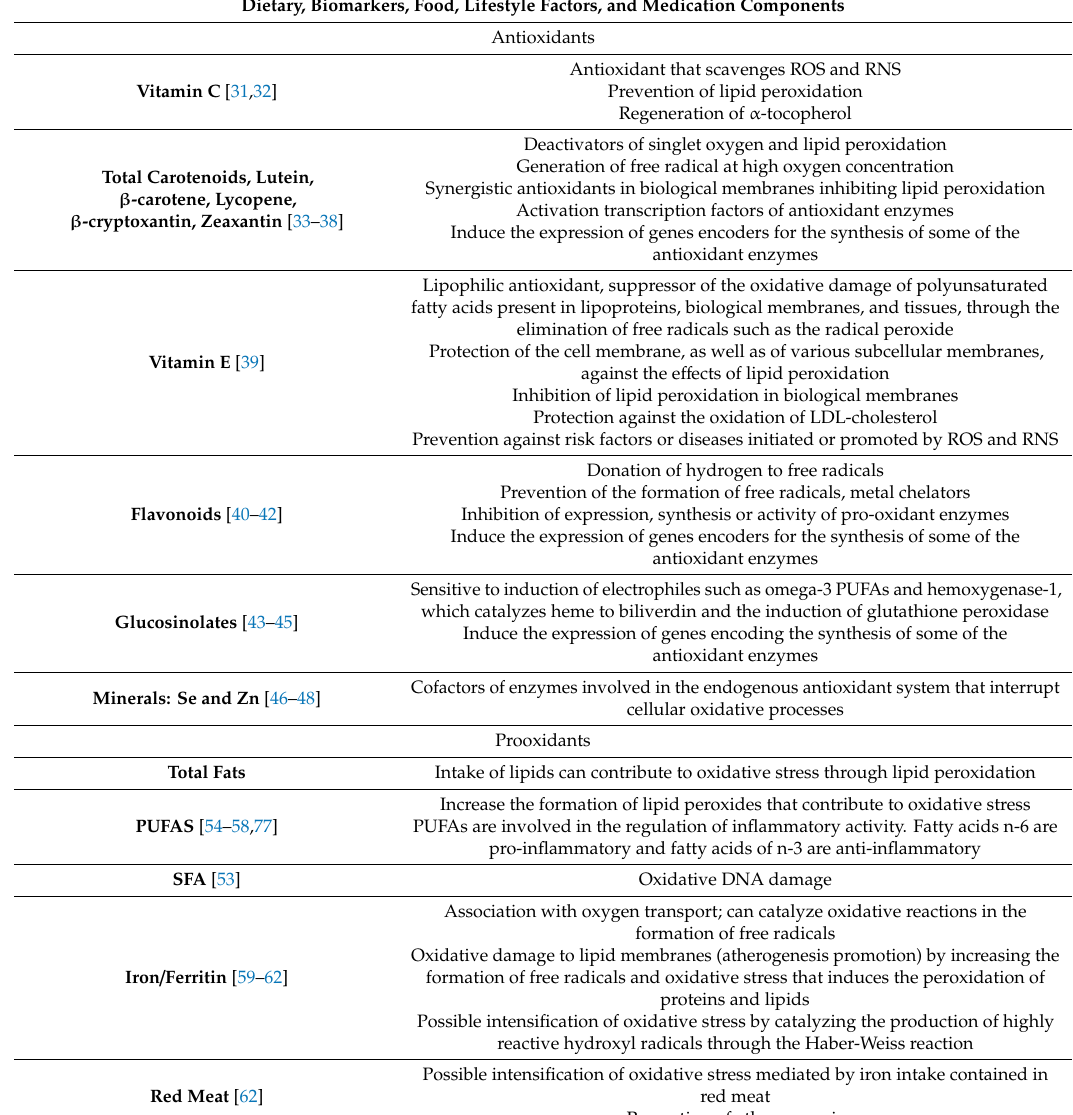
Table 6. Rationale for the inclusion of some components in a priori OBS in relation to OS. Dietary, Biomarkers, Food, Lifestyle Factors, and Medication